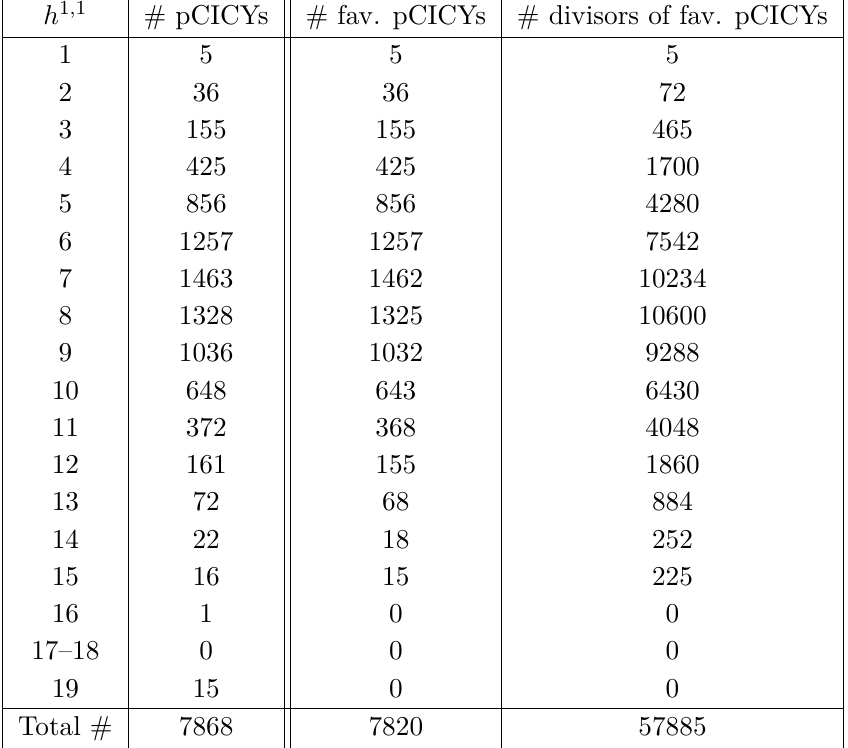
Table 1 . Number of pCICYs and their divisors for 1 ≤ h 1 , 1 ≤ 15